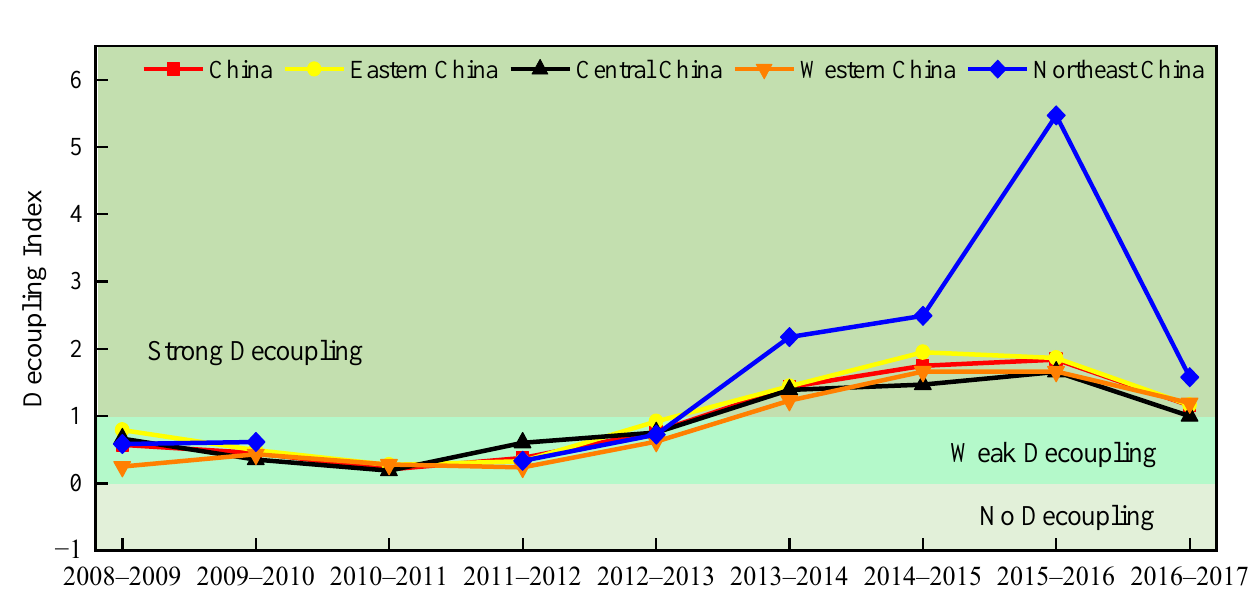
Figure 4. Decoupling trends of PM 2.5 emissions from 2008 to 2017.